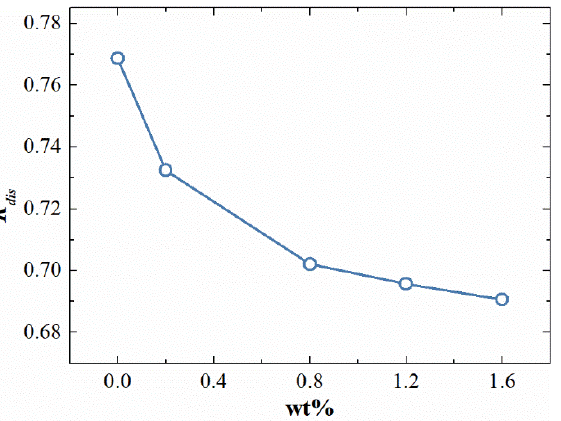
Figure 19. Pre-adsorption capacity of CH 4 in the composite shale reservoir with different water contents.